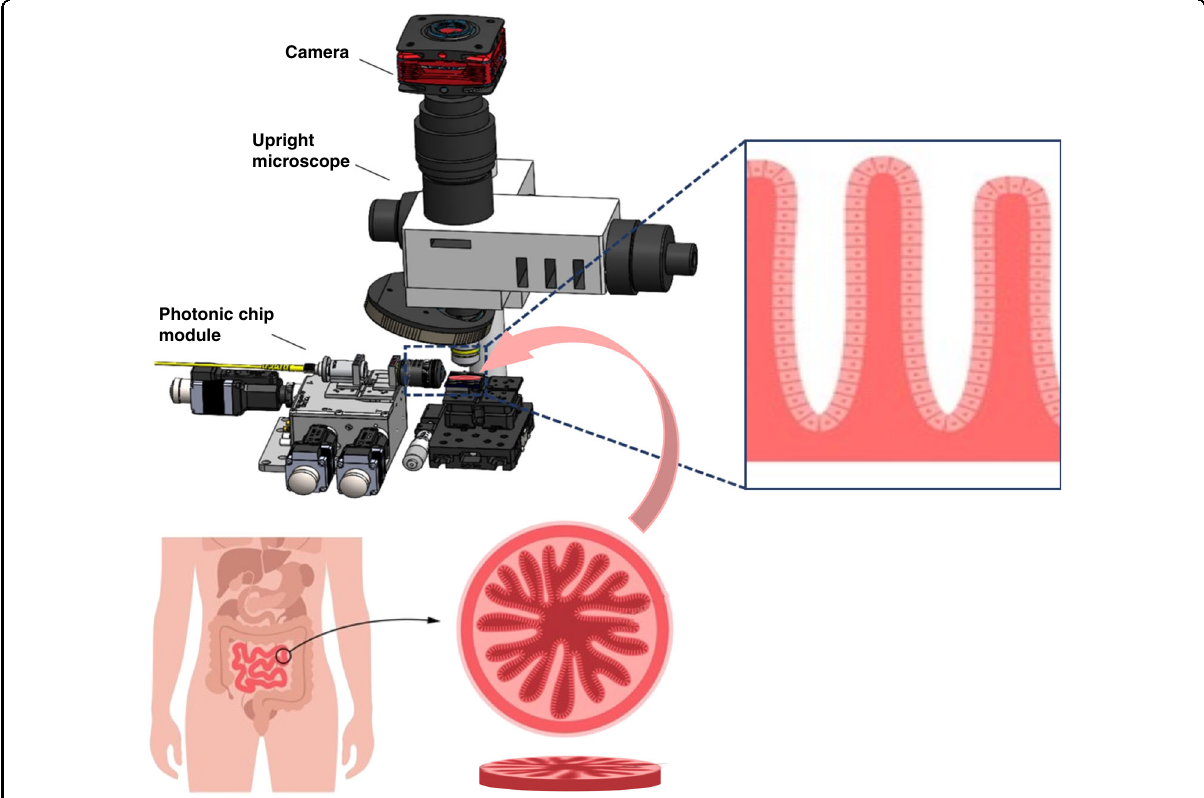
Fig. 1 Schematics of chip-based nanoscopy for histopathology. Diagram of chip-based nanoscopy setup extracted from the publication by Villegas-Herandez et al. 9 and sketch of a histology sample for intestine tissue for illustration